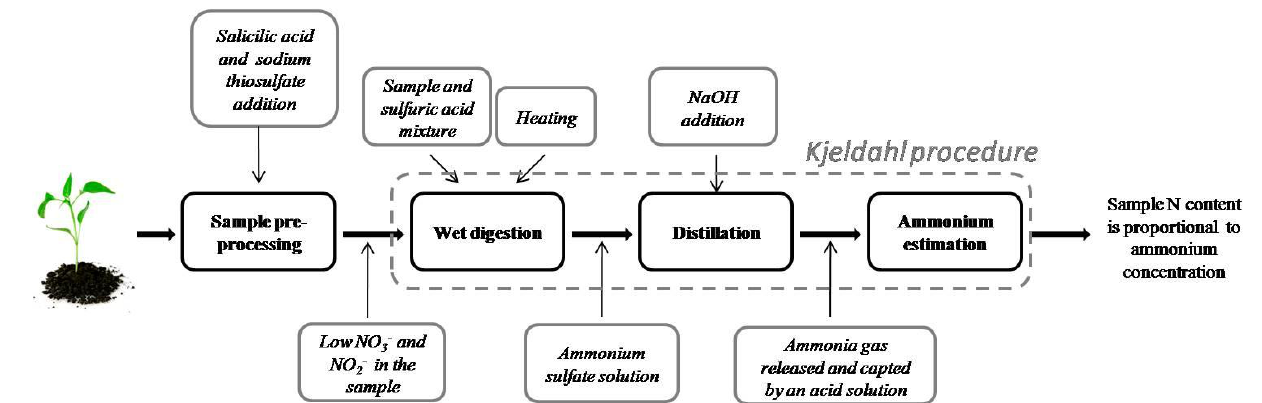
Figure 2. Kjeldahl wet digestion